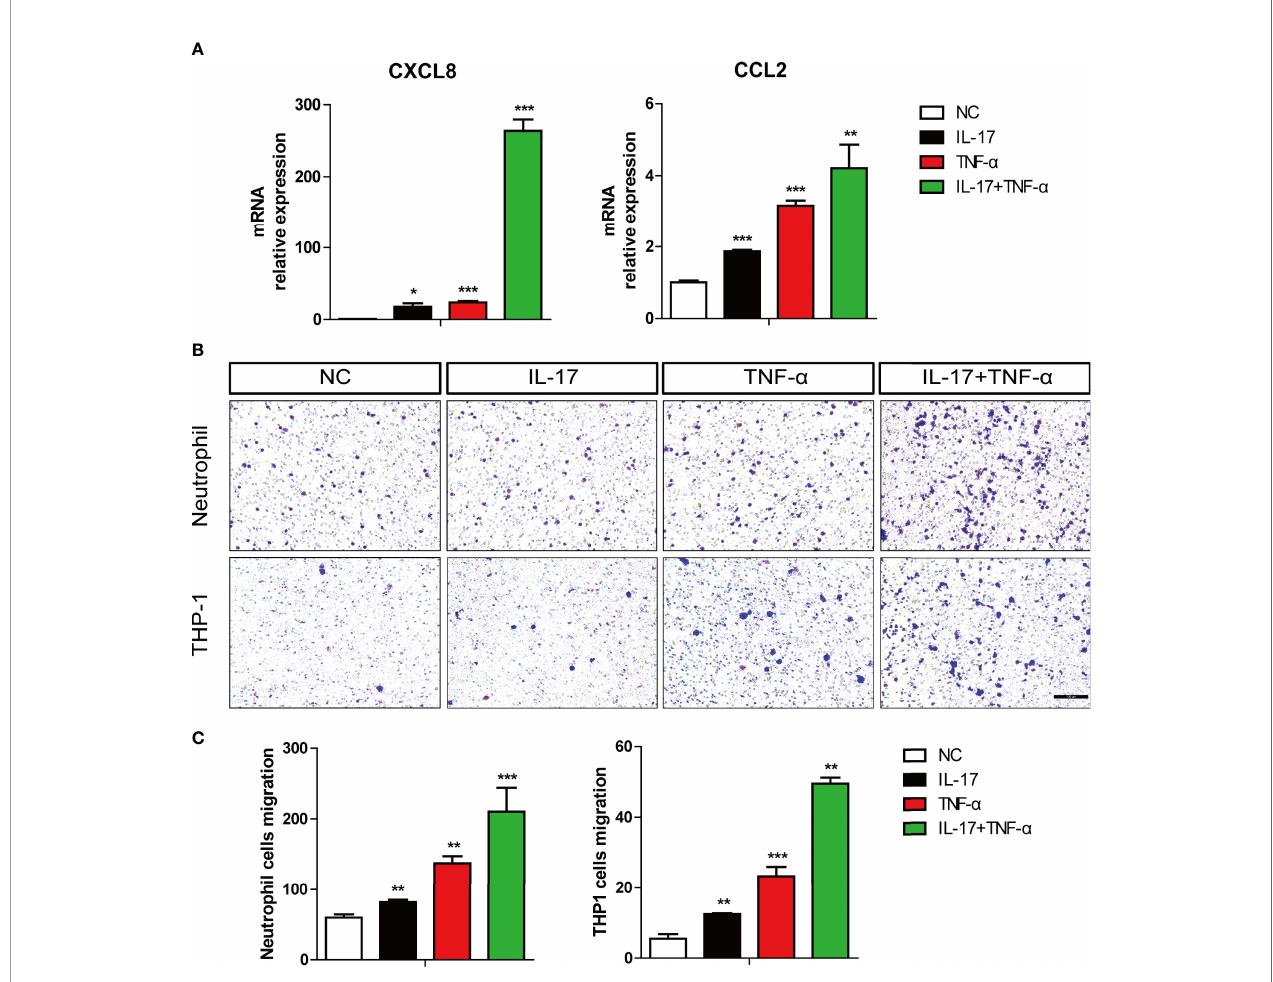
FIGURE 3 | The combination of IL-17 with TNF- a largely increased the chemotaxis of THP-1 cells and human neutrophils. (A) Porcine aortic endothelial cells (PAECs) were treated with rhIL-17 (100 ng/ml), rhTNF- a (2 ng/ml), or rhIL-17 plus rhTNF- a for 0 or 6 h. The induction of CXCL8 or CCL2 mRNA was measured via real-time PCR. (B) The PAECs were treated with IL-17, TNF- a , or IL-17 plus TNF- a for 48 h, and the supernatant was collected for chemotaxis assays. Human neutrophils or THP ‐ 1 cells were used to assess cell migration. (C) The number of migrating cells per fi eld was determined as in (B) . Data are representative of at least three independent experiments (mean ± SEM). * p < 0.05, ** p < 0.01, *** p < 0.001, determined by Student ’ s t